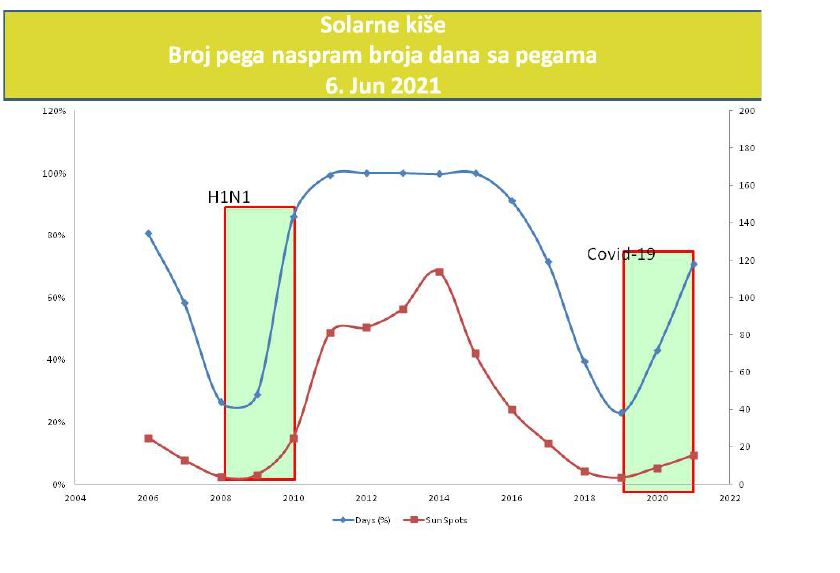
Figure 10 – INSTRUMENT 6: Sunspot numbers in the period 2004-2021. The blue line represents the number of days with sunspots. Note that a cycle of rising and declining in the number of sunspots is approximately 11